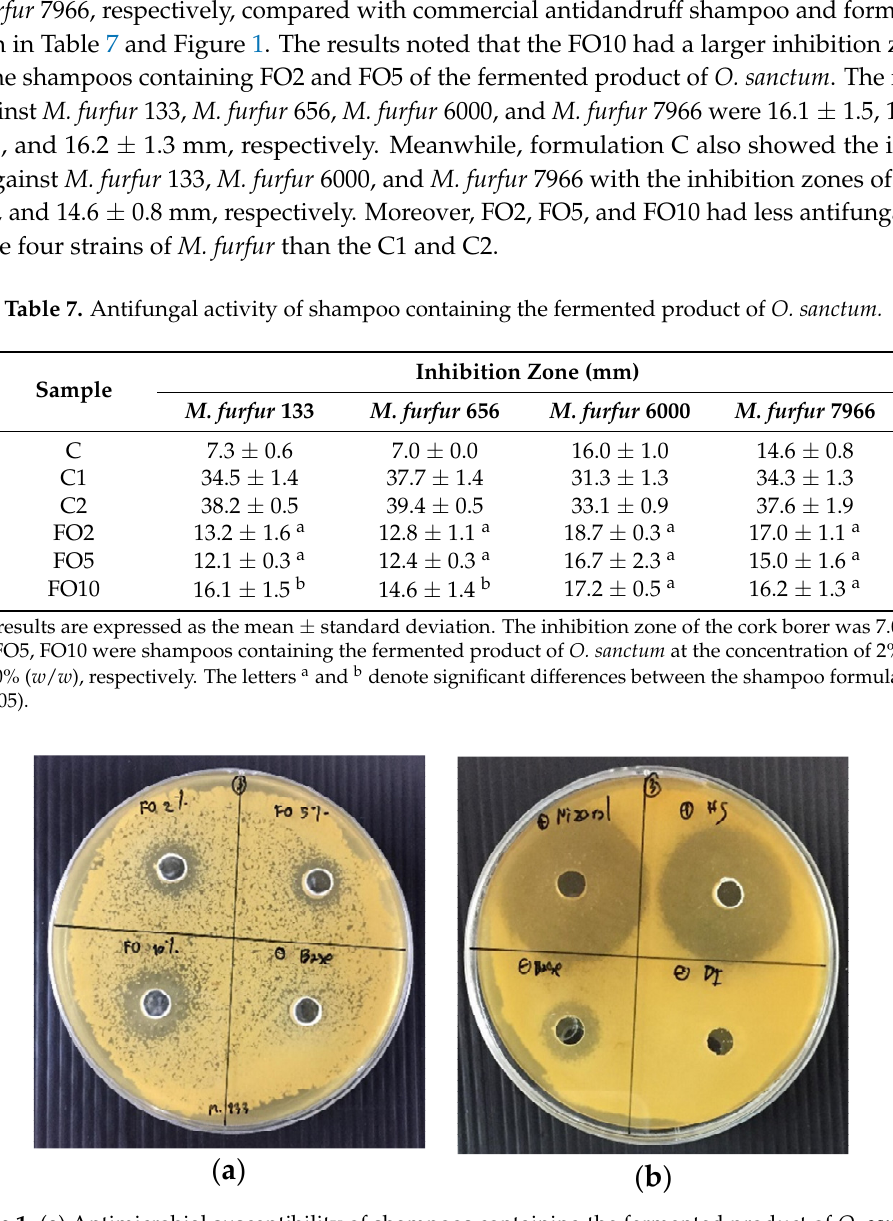
Figure 1. ( a ) Antimicrobial susceptibility of shampoos containing the fermented product of O. sanctum . Shampoo containing the fermented product of O. sanctum . Top left: shampoo containing 2% ( w / w ) of the fermented product of O. sanctum (FO2); top right: shampoo containing 5% ( w / w ) of the fermented product of O. sanctum (FO5); bottom left: shampoo containing 10% ( w / w ) of the fermented product of O. sanctum (FO10); bottom right: shampoo base (Base). ( b ) Antimicrobial susceptibility of commercial shampoos; top left: C1; top right: C2; bottom left: formulation C; bottom right: DI water.